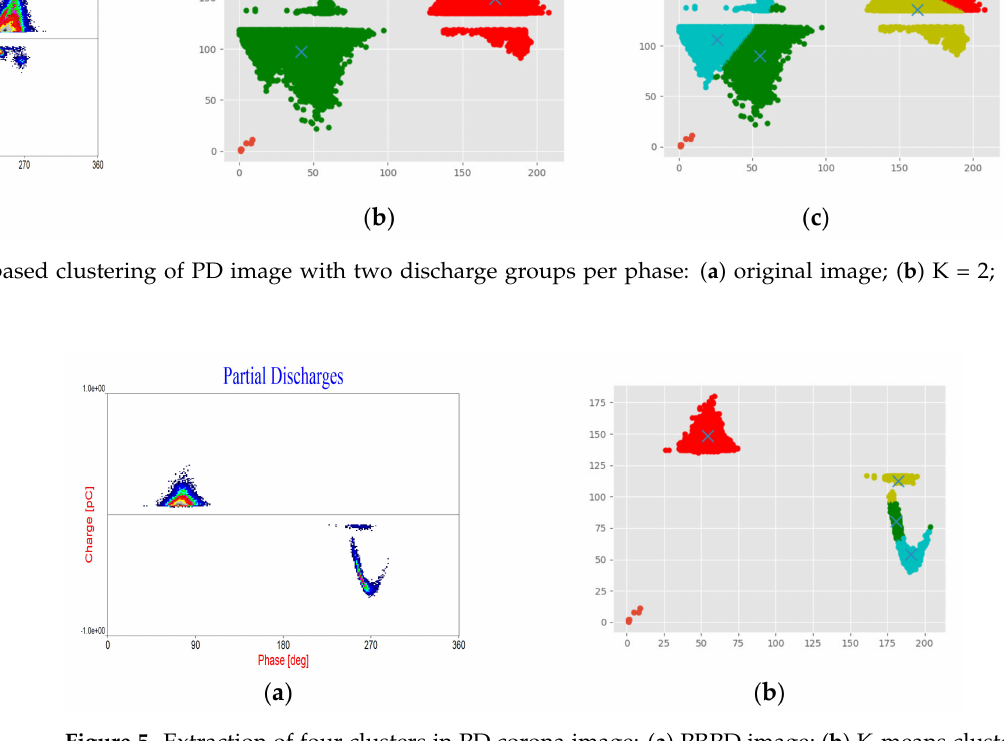
Figure 5. Extraction of four clusters in PD corona image: ( a ) PRPD image; ( b ) K-means clustered